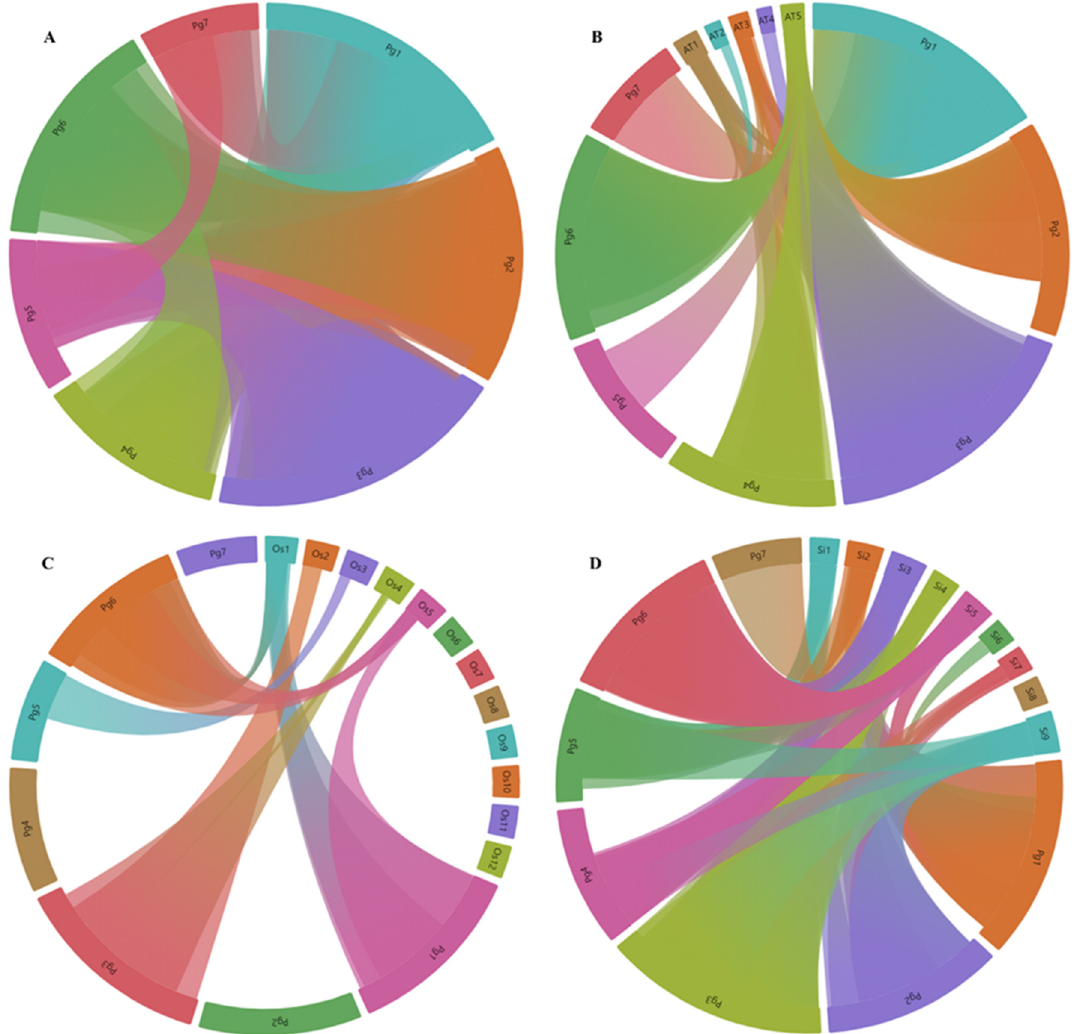
Figure 4. Synteny relationship of MYB family members between P. glaucum , A. thaliana , O. sativa and S. italica . Each connected colored line shows orthologous and paralogous pairs among the species. ( A ) Paralogous relationship in P. glaucum ( B ) Orthologous relationship between P. glaucum and A. thaliana ( C ) Synteny relationship between P. glaucum and O. sativa ( D ) Synteny relationship in P. glaucum and S. italica.